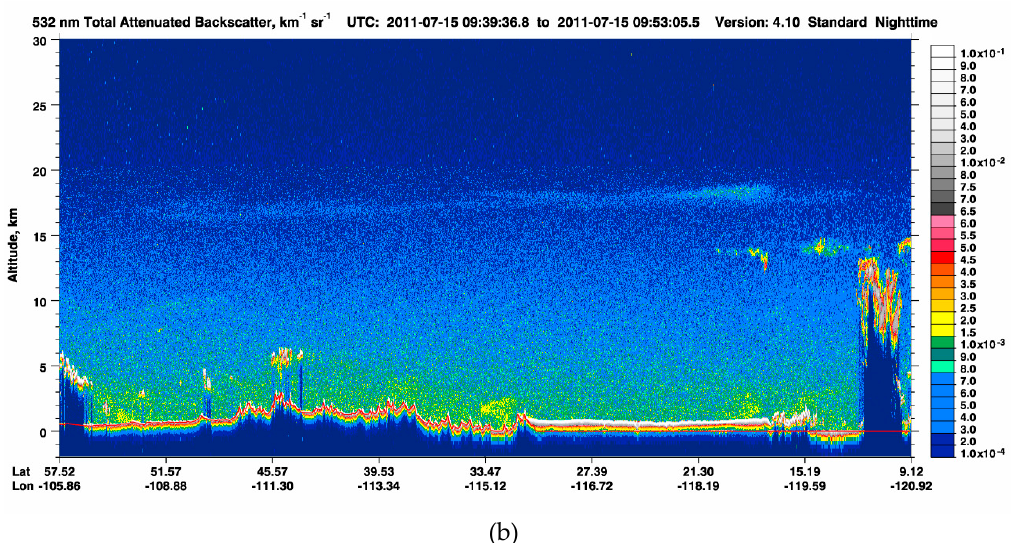
Figure 13. ( a ) Multiple sub-km aerosol layers over the Arctic on 10 July 2009 after the